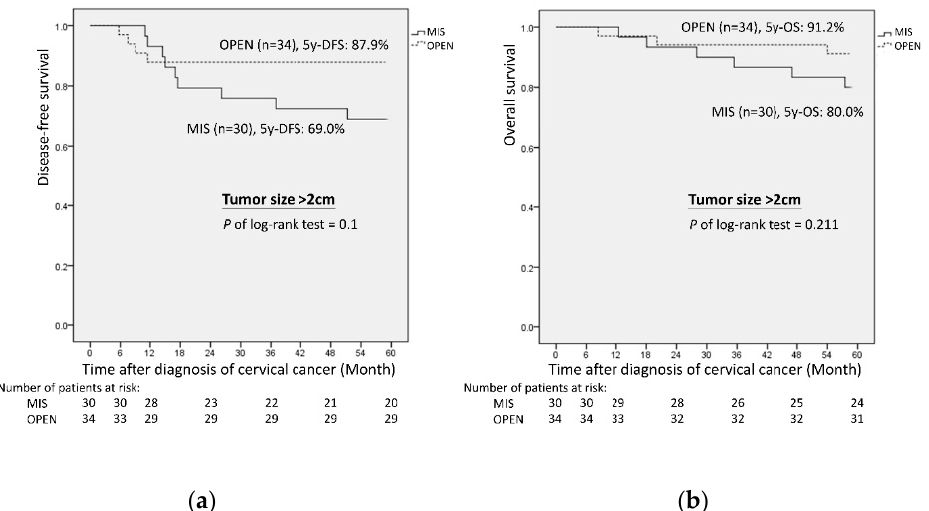
Figure 3. Oncologic outcomes of MIS versus open radical hysterectomy with pathologic tumor size > 2 cm: ( a ) 5-year disease-free survival; ( b ) 5-year overall survival. Table 4. Univariate and multivariate regression analysis with overall survival and disease-free survival as the